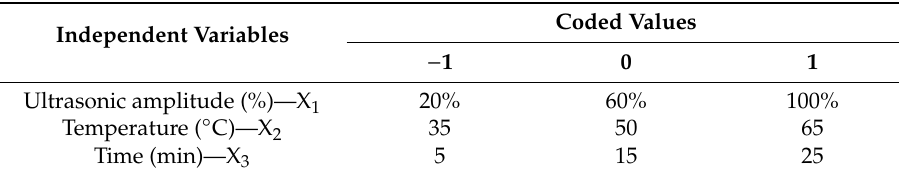
Table 1. Actual and coded values of experimental